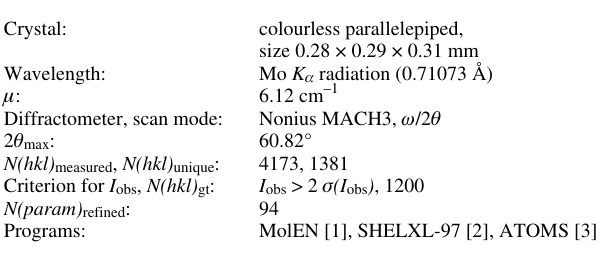
Table 1. Data collection and handling.